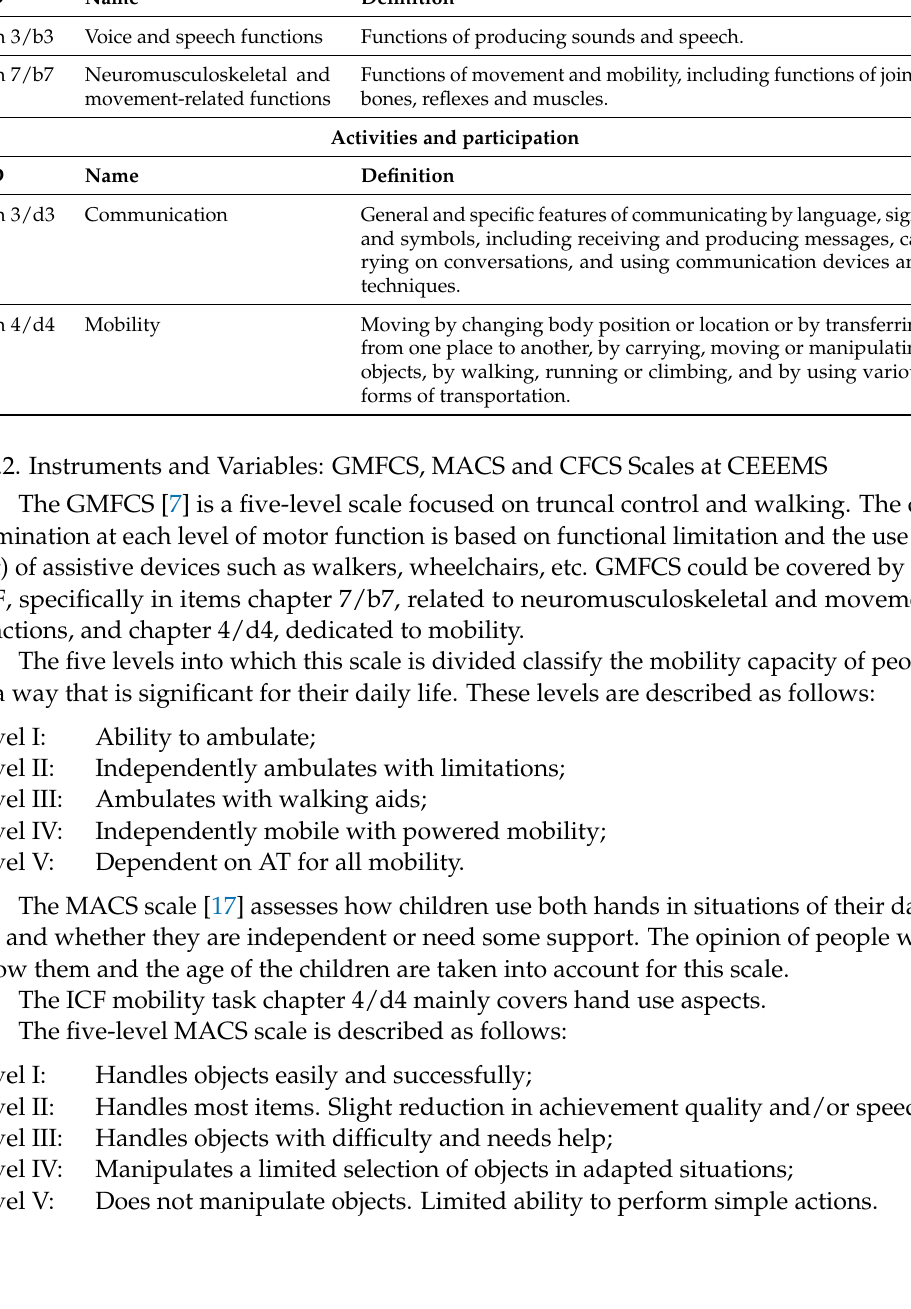
Table 1. Motor functions and communicative skills included in the ICF scale. Body